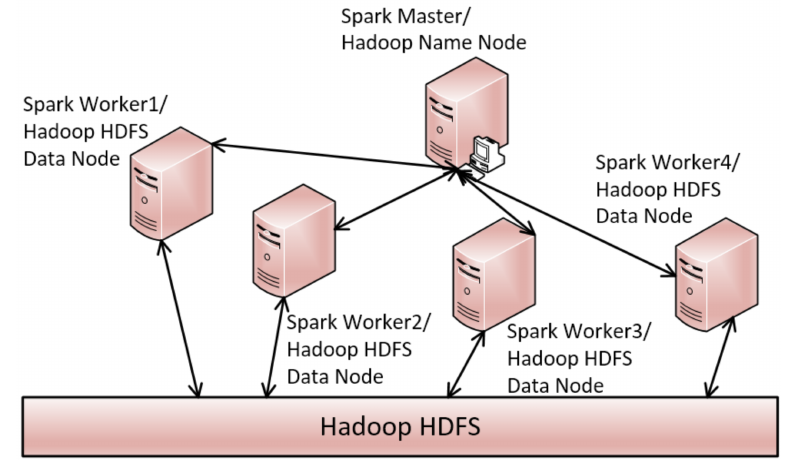
Figure 6. Distributed Triangle Increment Tree (DTI-Tree) system architecture.